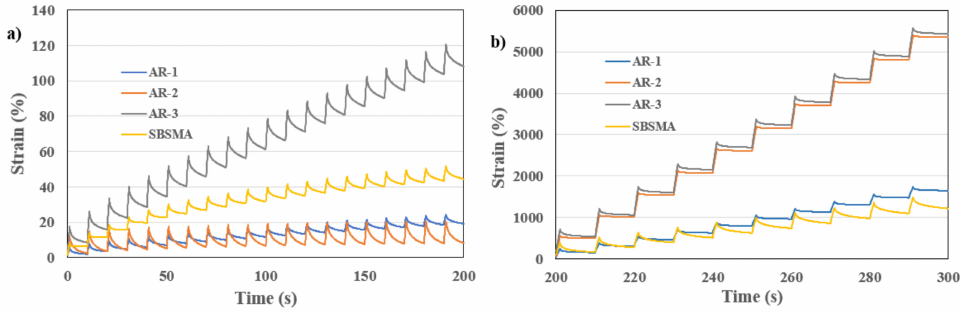
Figure 4. MSCR results at 64 ◦ C. ( a ) load of 0.1 kPa; ( b ) load of 3.2 kPa. Table 7. Recovery rate (R) and non-recoverable compliance (Jnr) at 64 ◦ C.